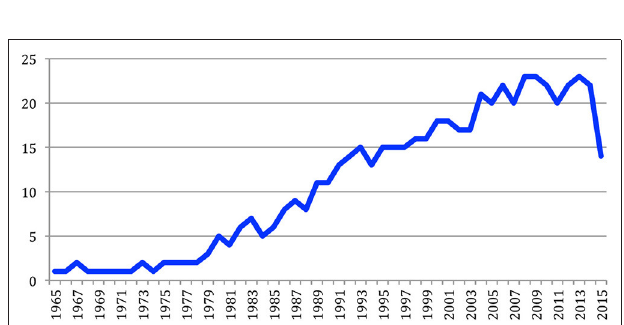
FIGURE 5 | Number of sources (conferences and journals) considered each year.